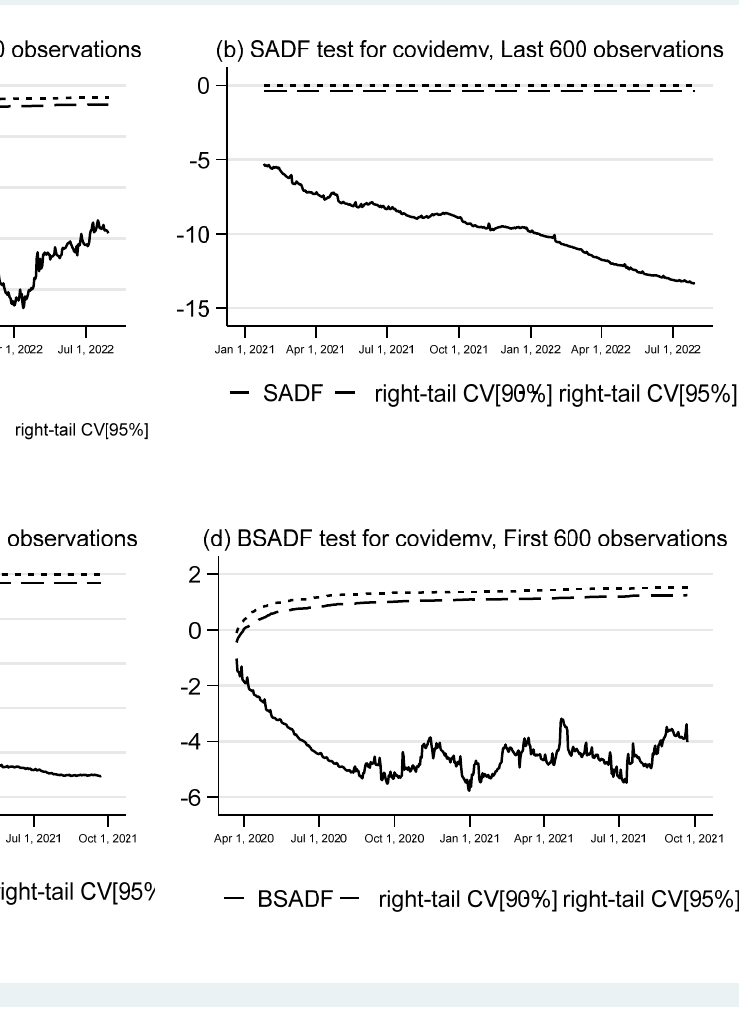
Figure 3. Date stamping the explosive behavior of COVIDEMV